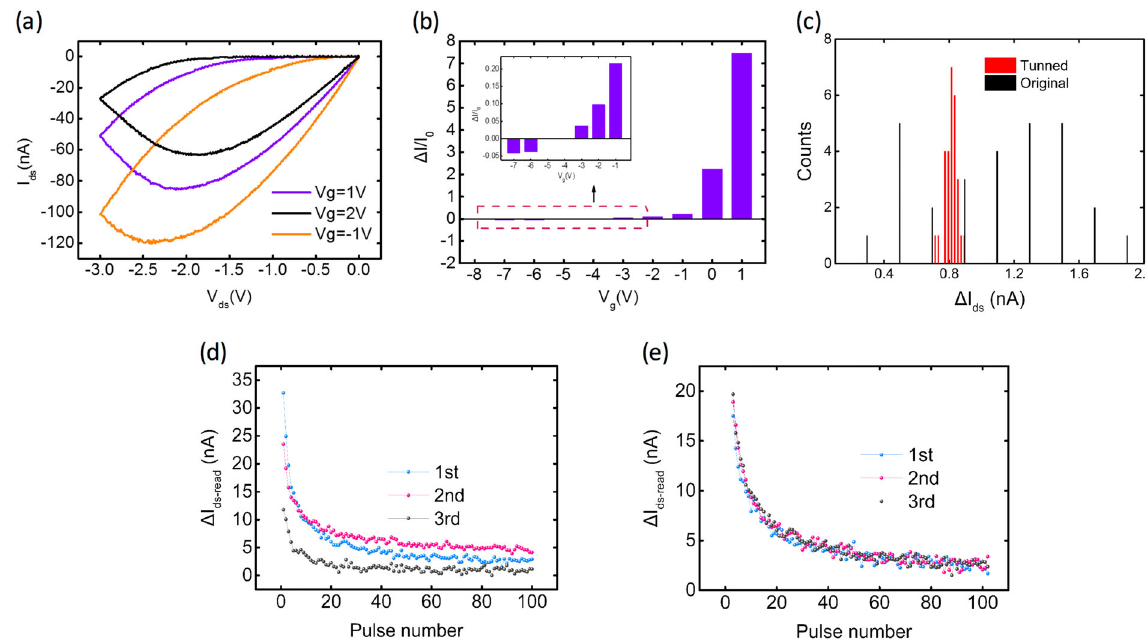
Fig. 3 Gate-tuning function of the FMT. a I – V scanning at different V g biases. b Responses to identical V ds pulses ( − 5 V, 1 s) at different V g . a, b were tested on a device with L = 20 µm and W = 50 µm. c The current change per pulse at V ds = − 4 V 10 ms for 28 devices at the same V g = 0 V (original) and different V g (tuned). d Three tests without gate initialization. e Three tests with V g from − 2 V to 2 V, V ds = 0.1 V IV -scanning initialization. c – e were tested on a device with L = 60 µm and W = 100